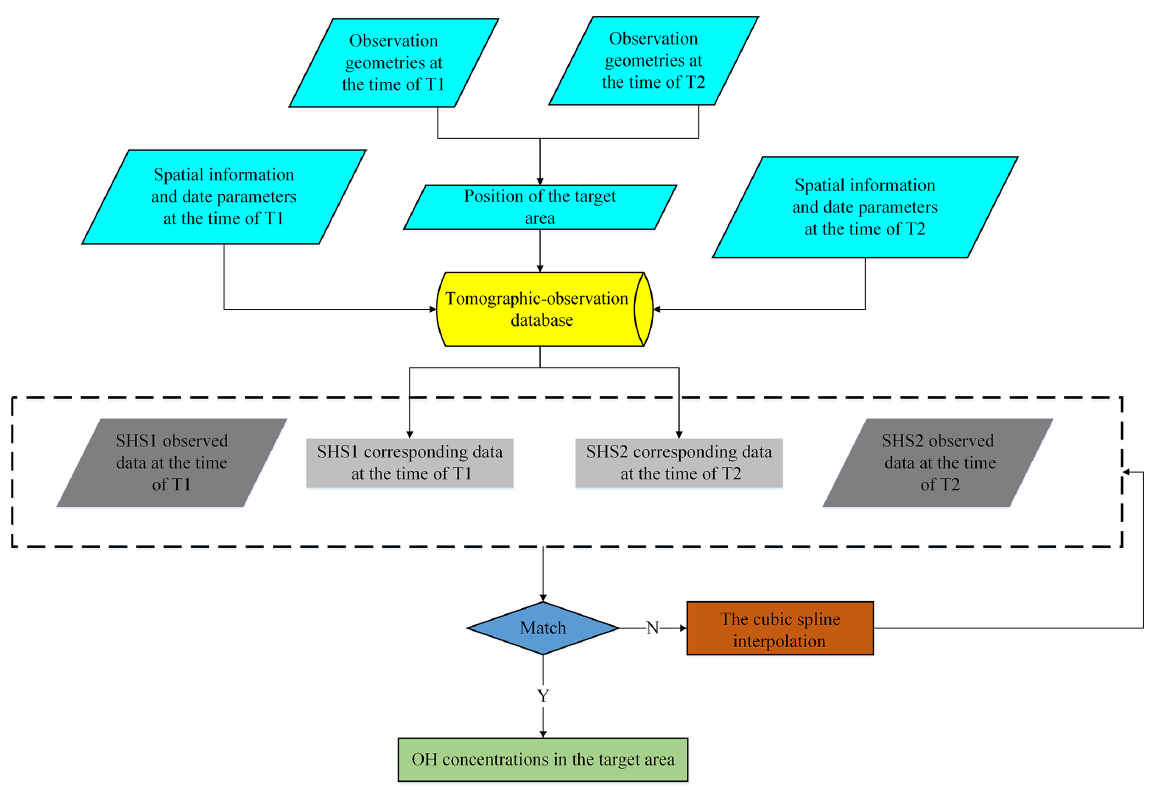
Figure 16. Flowchart of the tomographic retrieval algorithm. The OH concentrations can be obtained from the tomographic-observation database or by the cubic spline